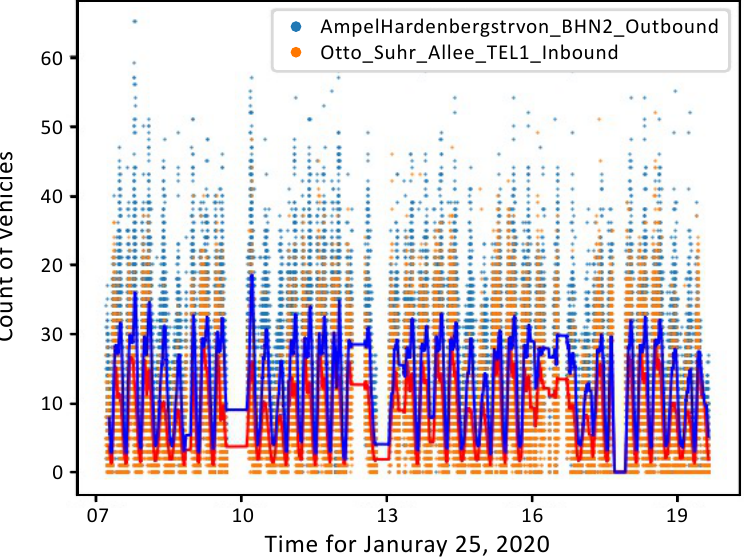
Figure 11. Scatter plot of five minute average vehicle count of two selected locations highlighting a traffic interruption on 25 January 2020.